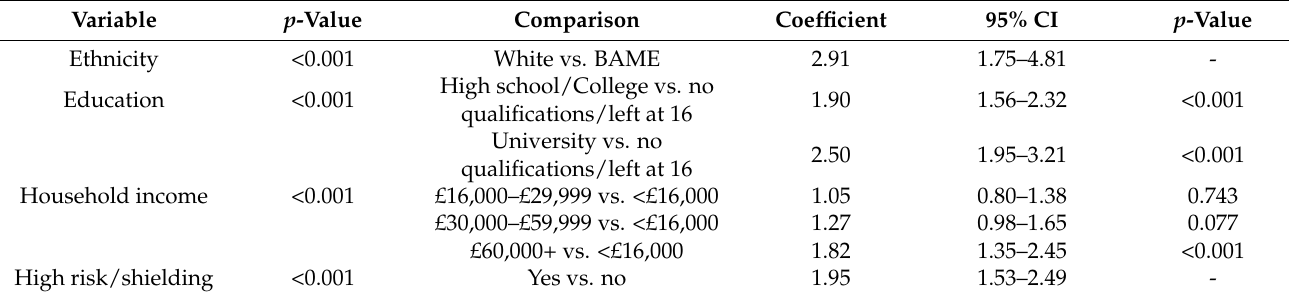
Table 4. Multivariate analysis of sociodemographic factors and intention to accept a COVID-19 vaccine.